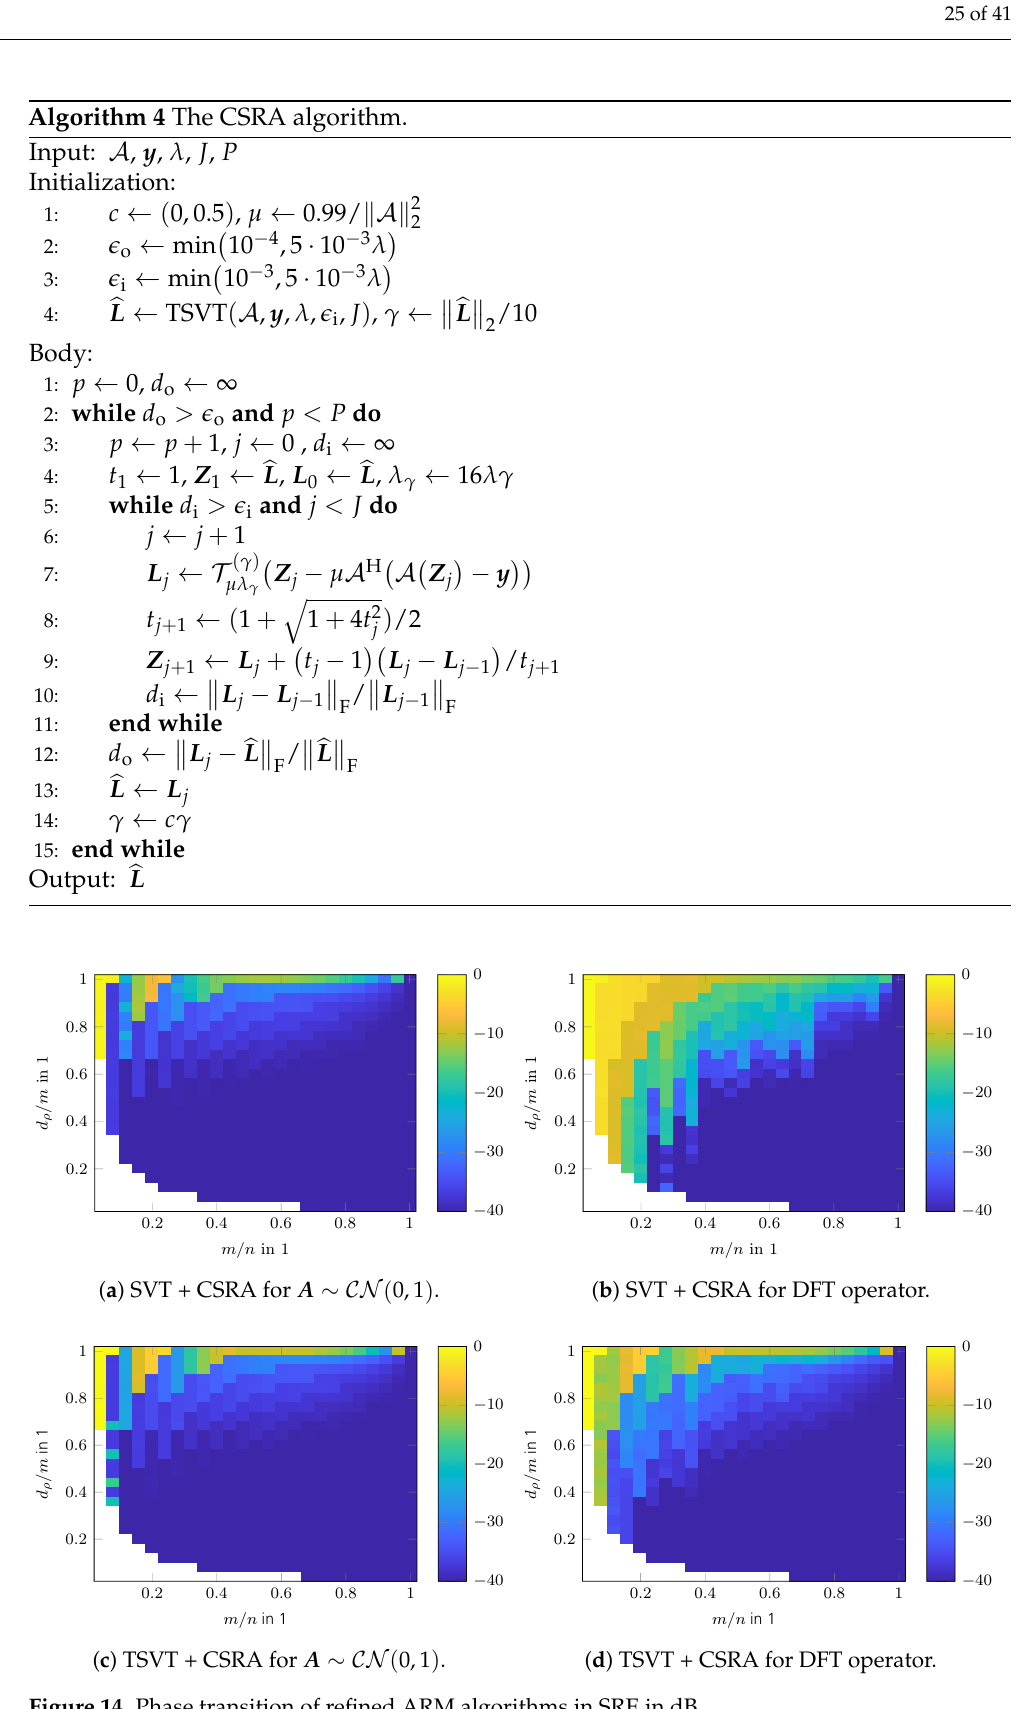
Figure 14. Phase transition of refined ARM algorithms in SRE in